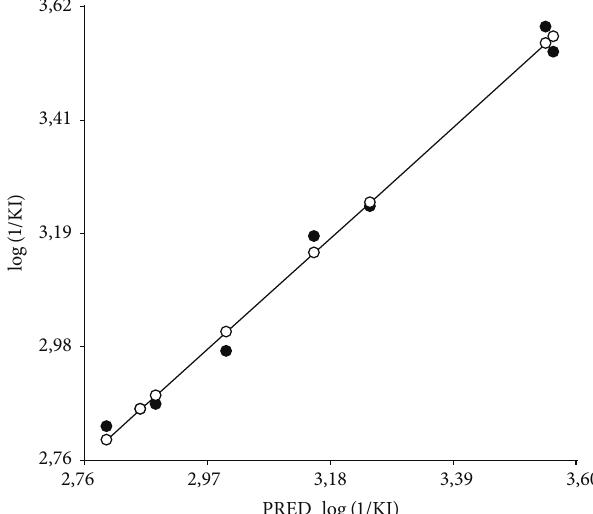
Figure 9: Multiple linear regression analysis (MLR) calculated to examine quantitative relationships between linear combinations of the dependent variable log (1/LD 50 ) and the predictor variables (structure and molecular properties). Plot of calculated versus experimental log(1/LD 50 ) of insecticidal activity against Triatomi- nae bugs (vector of Chagas